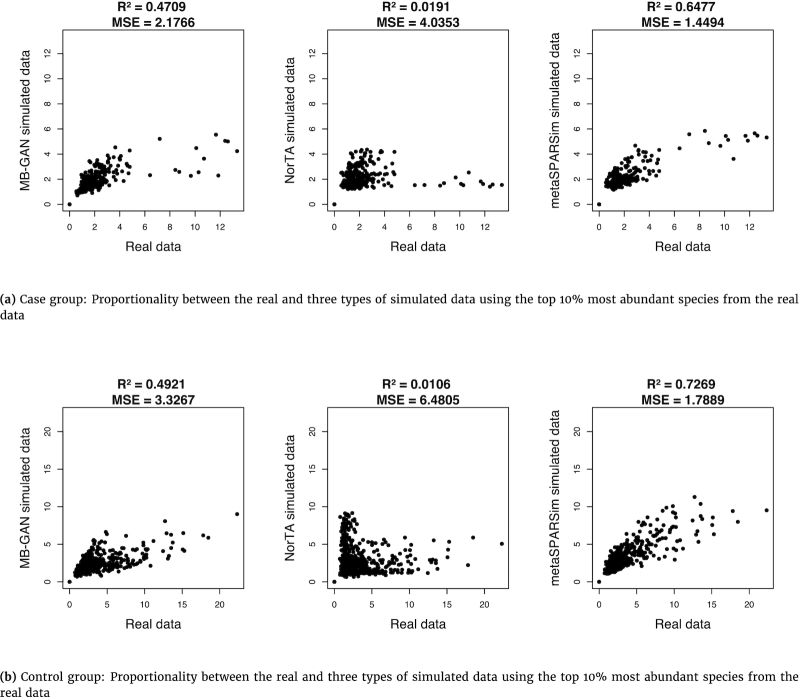
Scatter plot of the “goodness-of-fit proportionality” statistic between the real and the simulated data by MB-GAN, Normal-To-Anything (NorTA), and metaSPARSim. Results are calculated based on the top 10% most abundant species from the real data of the (a) case and the (b) control group.